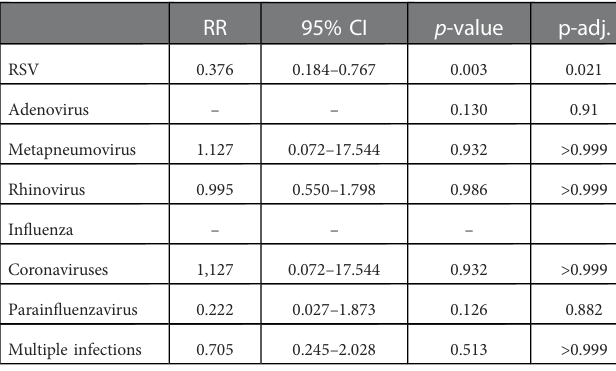
TABLE 4 Effect of lockdown on the pathogen